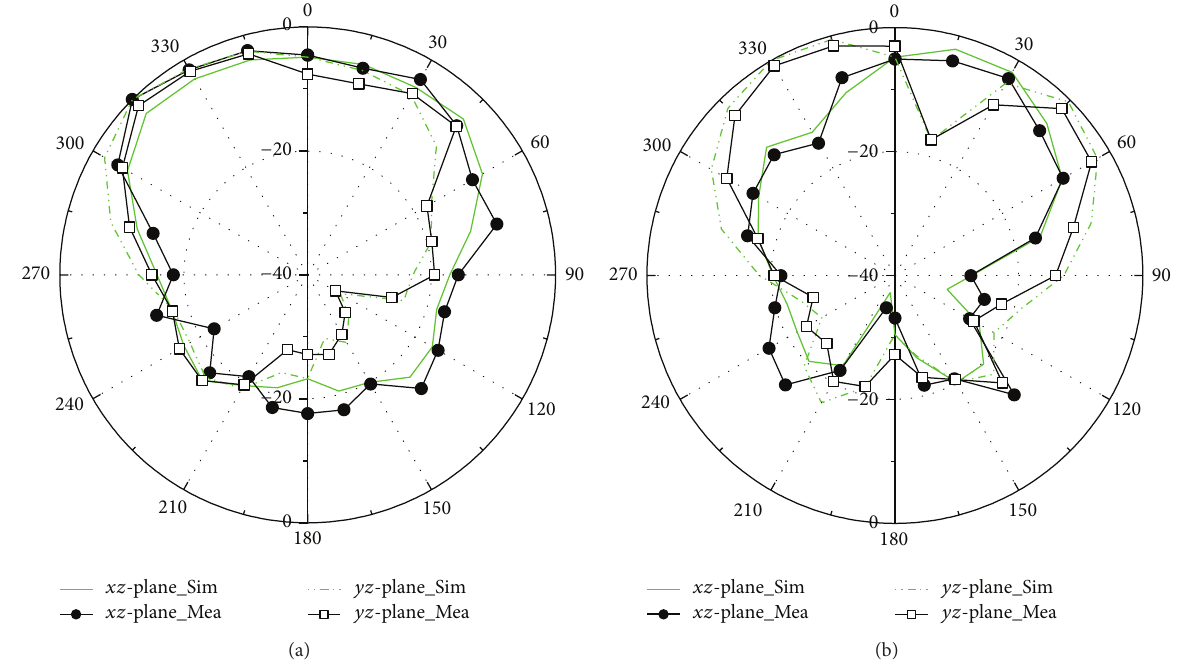
Figure 13: Simulated and measured radiation patterns of the proposed antenna: (a) 5.18 GHz and (b) 5.77 GHz.